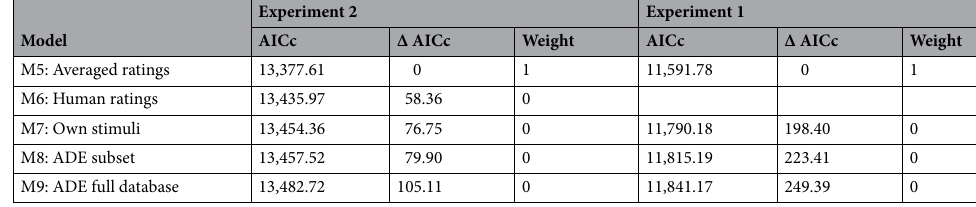
Table 2. Comparison of models using different measures of object specificity and frequency to predict basic-level scene categorization accuracy in Experiment 2 and, as a validation, in Experiment 1. Displayed are AICc values comparing non-nested models predicting basic-level scene categorization accuracy by different measures of object specificity and frequency and the standardized covariates object size and